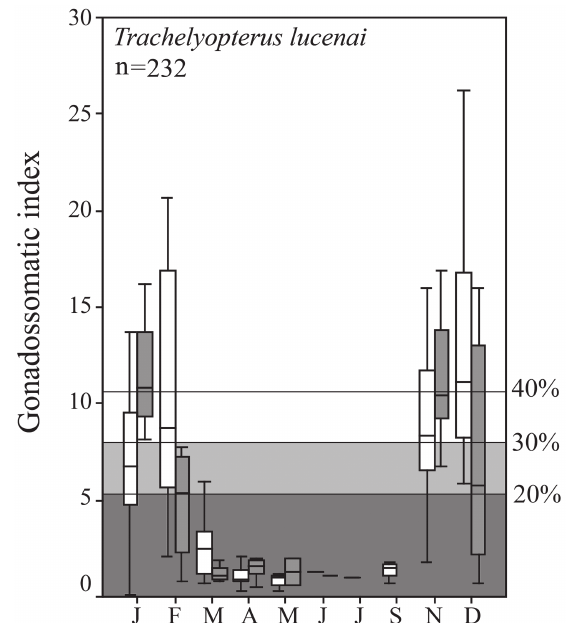
Fig. 10. Monthly variation of Trachelyopterus lucenai GSI values (adult females only) in Guaíba Lake (white) and Casamento Lake (dark gray), Rio Grande do Sul, Brazil (median, 25-75% quartiles and lower-upper GSI limits by month and site). Three GSI cut-off values were tested with respect to the maximum GSI recorded for each species, for delimitation of reproductive months: 20% (G and 40% (G ). 40